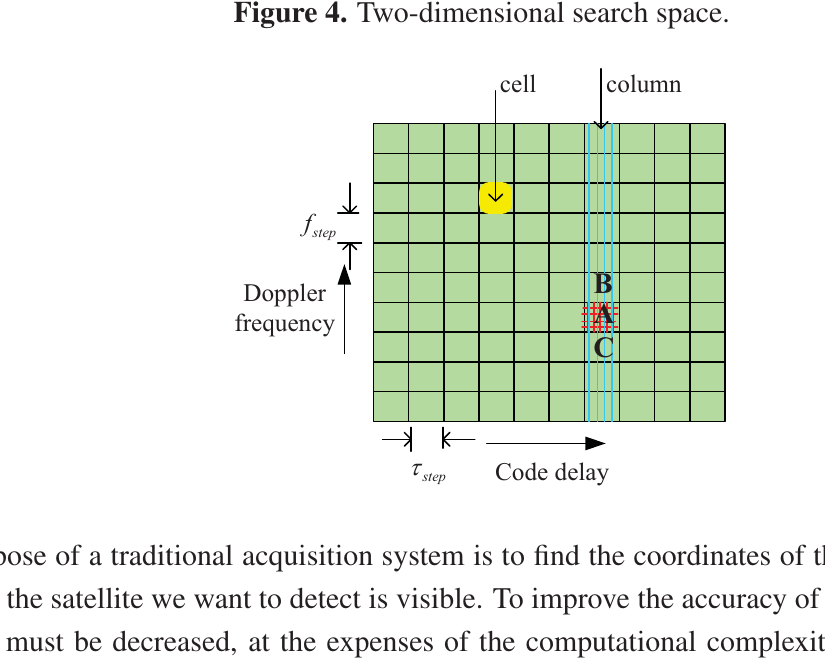
Figure 4. Two-dimensional search